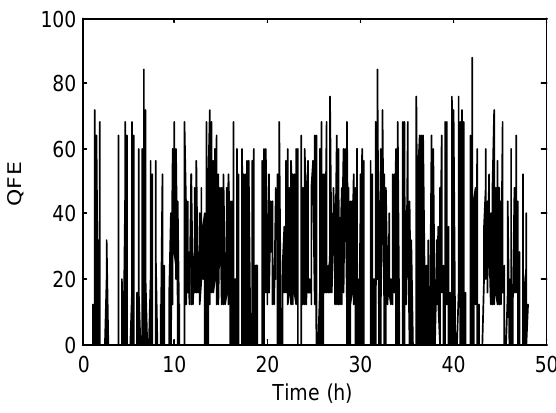
Figure 15. Function evaluation in the base case of fault 8.